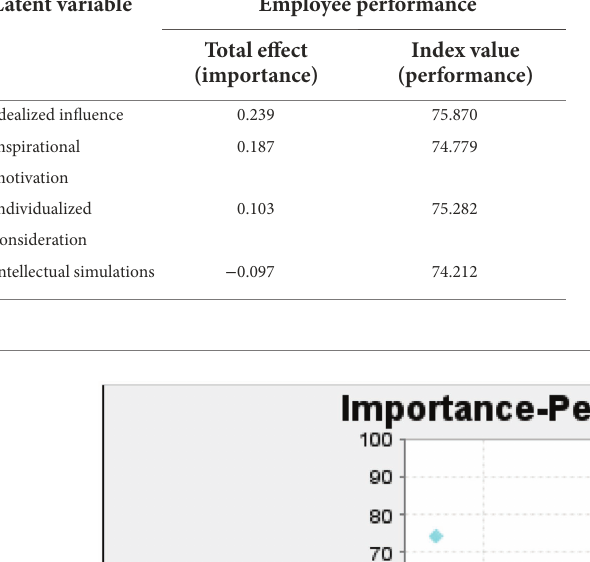
TABLE 5 IPMA results.